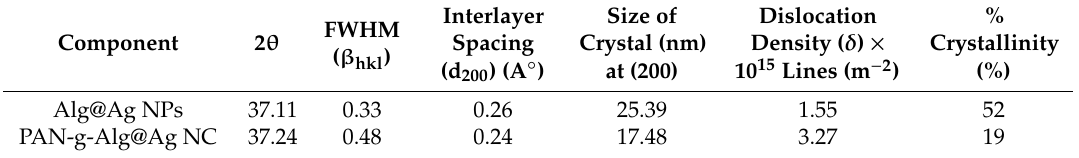
Table 1. XRD parameters of Ag NPs associated with the Alg and PAN-g-Alg copolymer matrix. Component 2 θ